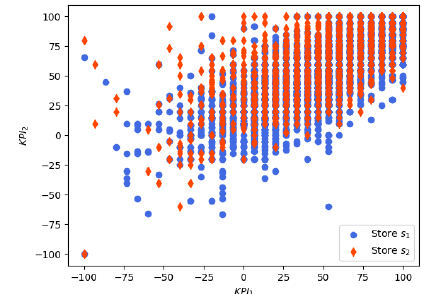
Figure 5. Point cloud representations of two stores. The left plot considers one KPI: KPI values are on the x-axis, and the absolute frequency is on the y-axis. The right plot considers two KPIs: KPI values are on the x-axis and y-axis, and each point represents a user.